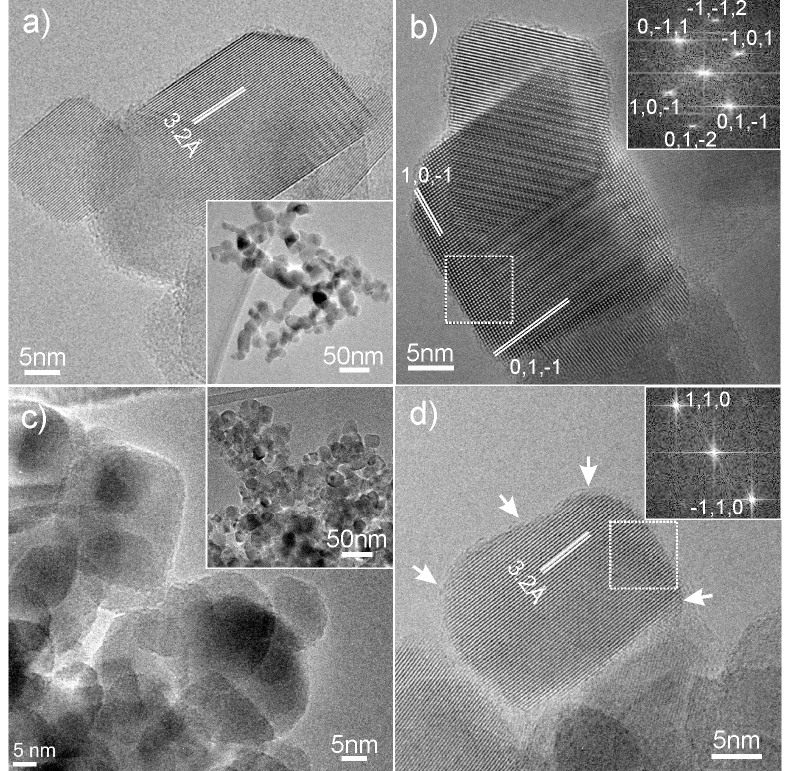
Figure 3. TEM images of TiO 2 ( a , b ) and S-doped TiO 2 ( c , d ). In the insets of ( a , c ) low resolution images of TiO 2 and S-doped TiO 2 are shown, while in the insets of ( b , d ) two selected regions are Fast Fourier Transform (FFT) imaged.